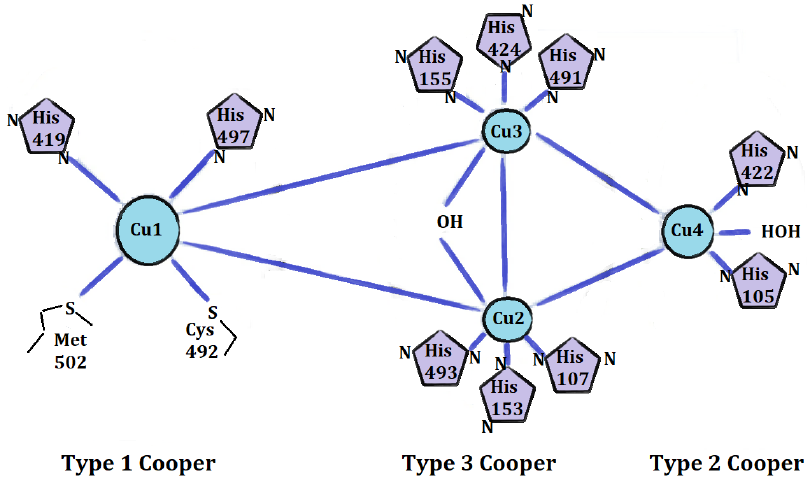
Figure 3. Structure of the active site of laccases (modified from [9]).